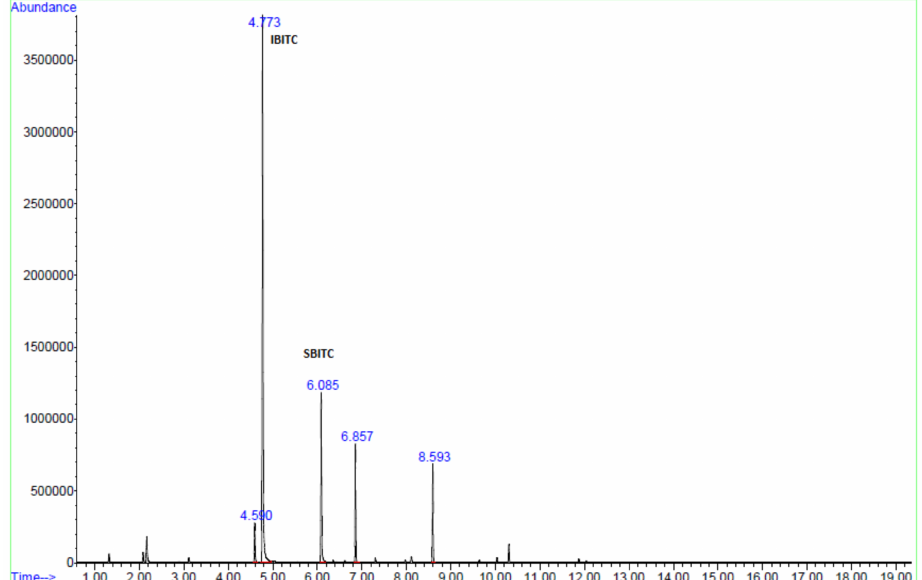
Figure 2. Total ion chromatogram (TIC) of volatile from headspace solid-phase microextraction (HS-SPME)-gas chromatography–mass spectrometry (GC/MS) analysis Sisymbrium officinale (L.)